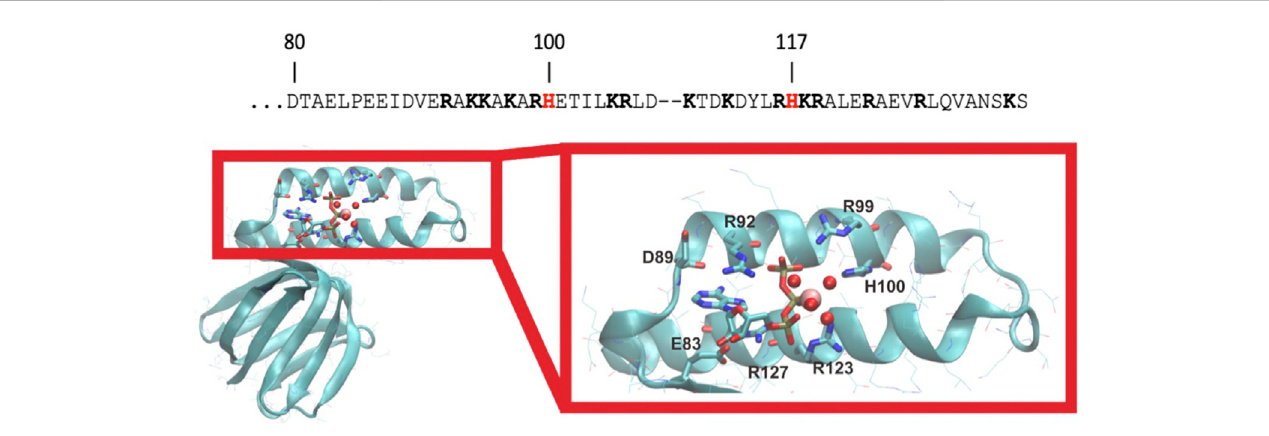
FIGURE 2 C. thermarum has unique histidine residues. The C-terminal helix amino acids of the ε subunit of C. thermarum (accession number are AFCE01000162) are shown with the unique histidine residues in red at positions 100 and 117 and other positive charged residues in bold type (top). Below this, a structural model of the ε subunit from C. thermarum in cyan (PDB ID: 5HKK) is displayed. The ligand-binding site structure is shown zoomed in on the right with the various features coordinating the ion highlighted. ATP is bound by ε E83, ε R92, ε R99, ε R123 and ε R127. ε H100 appears to stabilize Mg 2+ (pink sphere) binding via one of the bound water molecules (red spheres). ATP is depicted as a stick model with its phosphates associating with Mg 2+ and four water molecules.